Question: Draft a figure caption describing what is shown.
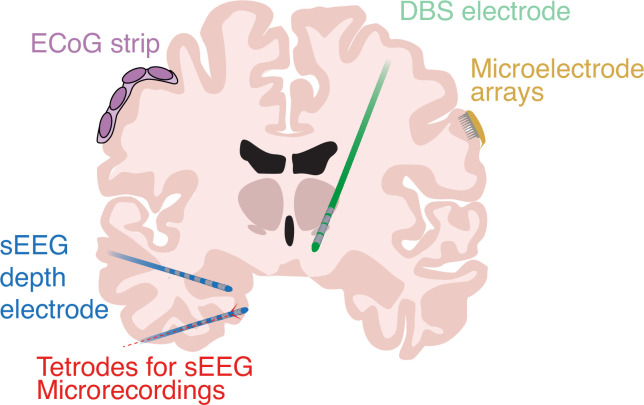
Answer: Different types of implants used for intracranial recordings in humans: electrocorticography (ECoG) strips or grids are typically placed under the dura mater (purple implant); Deep-brain stimulation (DBS) electrodes are typically used to record and stimulate subcortical regions (green implant); Microelectrode arrays are positioned on the cortex (yellow implant); stereo-encephalography (sEEG) depth electrodes are inserted in the brain across cortical and subcortical structures (blue implant). Hybrid models can record single-unit activity with either tetrodes (red) or microwires protruding from the electrode.